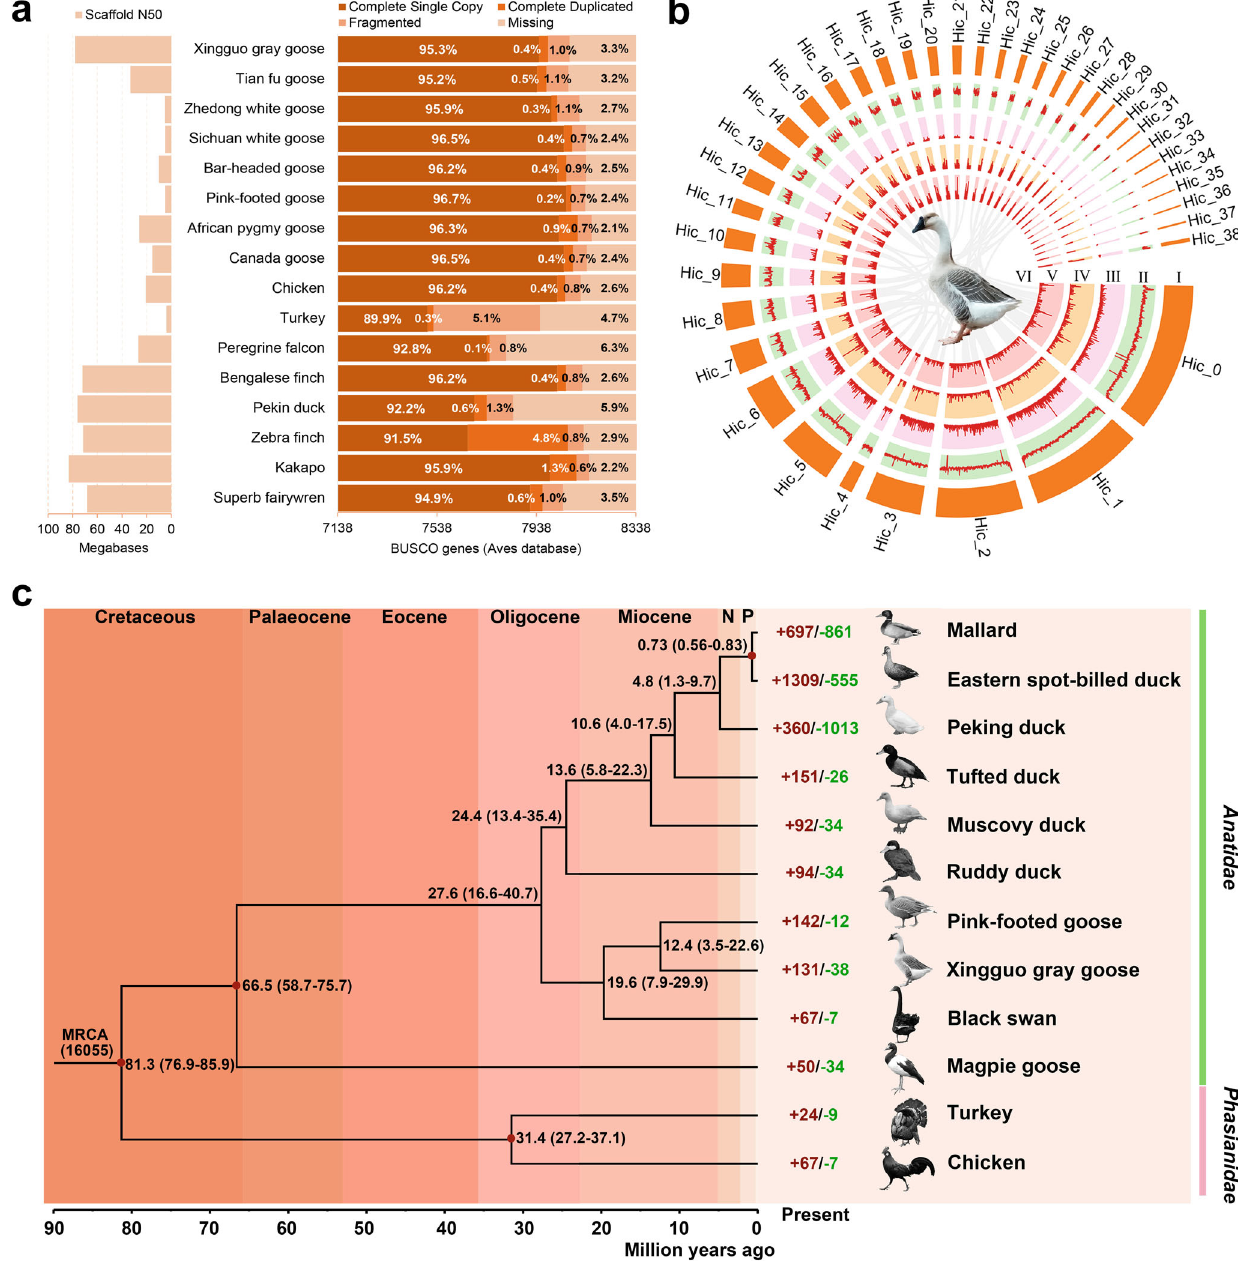
Fig. 2 Quality assessment of XGG genome and comparative genomic analysis. a Quality assessment of avian genomes. The left is the size of scaffold N50 and the right is the results of the evaluation using BUSCO Genes of Aves Database. b Genome landscape of the XGG. I, Chromosome number; II, GC density in 100-kb sliding windows; III, Repeat density; IV, Gene density of positive-strand ( + ); V, Gene density of negative strand ( – ); VI, Paralogous relationships in XGG chromosomes. c Phylogenetic tree and gene family expansion-and-contraction analysis. The red and green numbers represent the signi fi cantly expanded and contracted gene families, respectively. Divergence time was estimated based on four calibration points (red circles). N Pliocene, P Pleistocene, MRCA most recent common